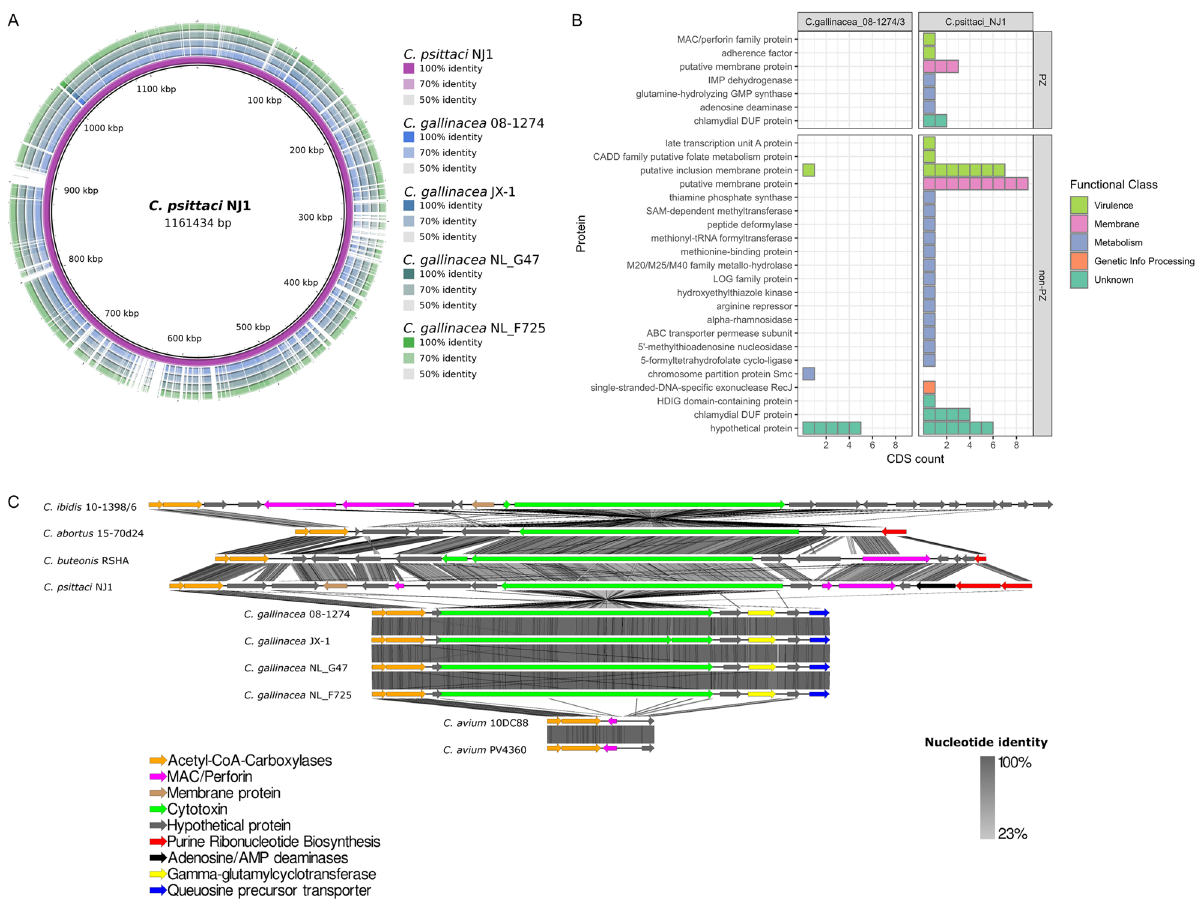
Figure 4. Genome comparison of C. gallinacea and C. psittaci. ( A ) Whole genome BLAST comparison between C. psittaci NJ1 and four C. gallinacea genomes (including Type strain 08-1274/03). The image is created with BLAST Ring Image Generator (BRIG) 49 and the first ring corresponds to the genome that was used for the comparison. ( B ) CDS for which no homologue (alignment E score higher than 1 × 10 −3 ) could be identified in C. gallinacea 08-1274/03 or C. psittaci NJ1. Every colored block in the figure corresponds to a CDS. The different proteins are categorized and colored according to their function and location. The figure was created using the tidyverse package and R v3.6.1 52,53 . ( C ) Graphical representation of the gene content of the PZs of representative Chlamydia species of avian origin including the Dutch C. gallinacea strains. Arrows represent PZ genes colored according to function (see key). Grey shading scale denotes % nucleotide identity. The image was created with Easyfig 50